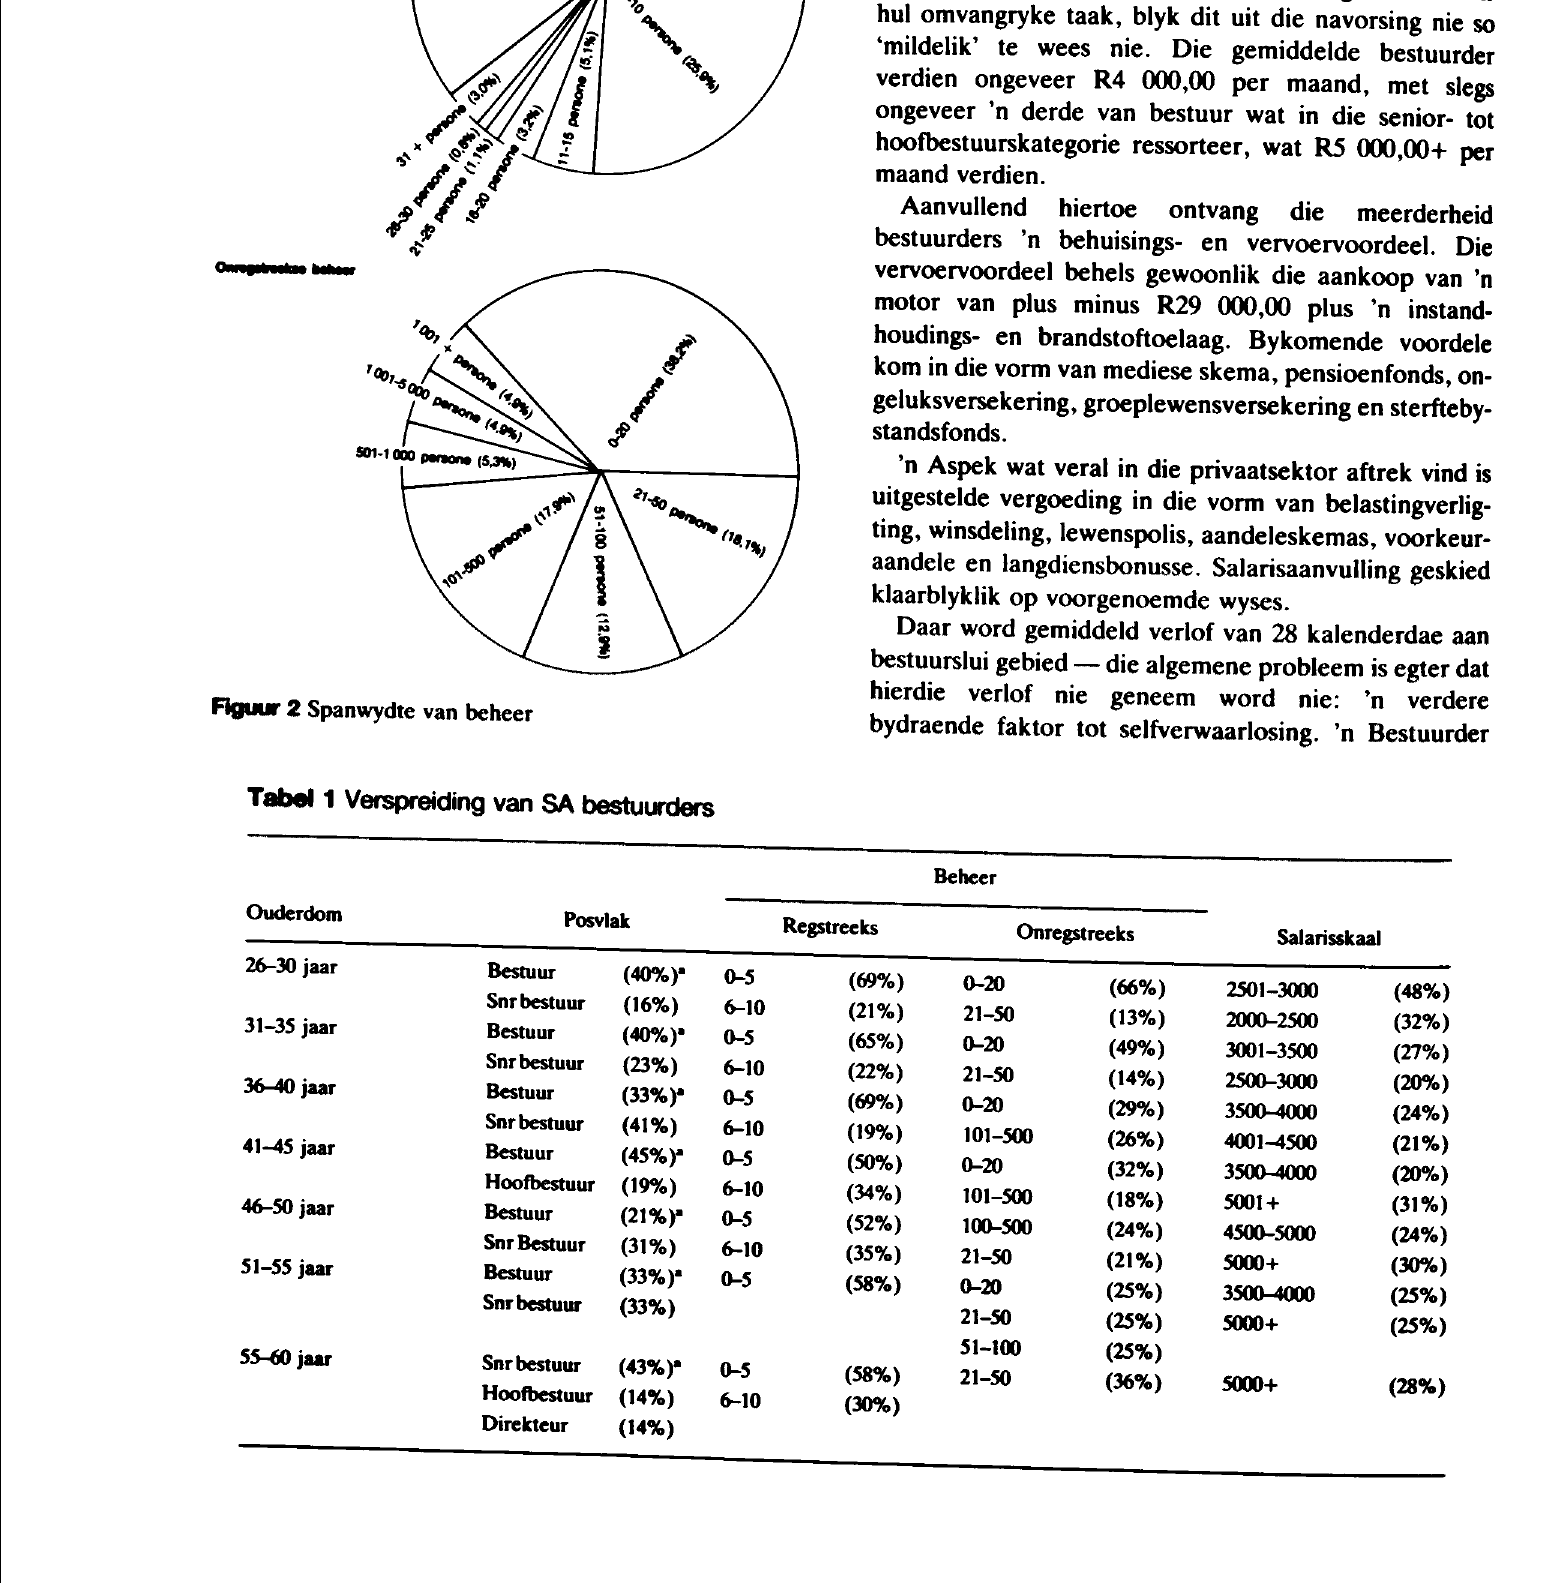
Tabel 1 Verspreiding van SA